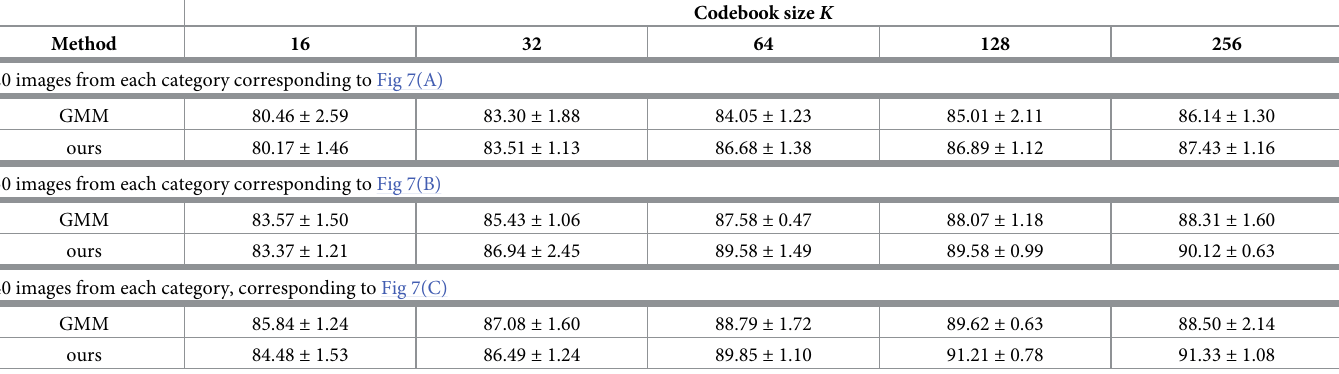
Table 9. Recognition performance (mean accuracy ± standard deviation) of the FVs with the GMM and ours (soft objective) codebooks on the Butterflies, corre- sponding to the Fig 7.